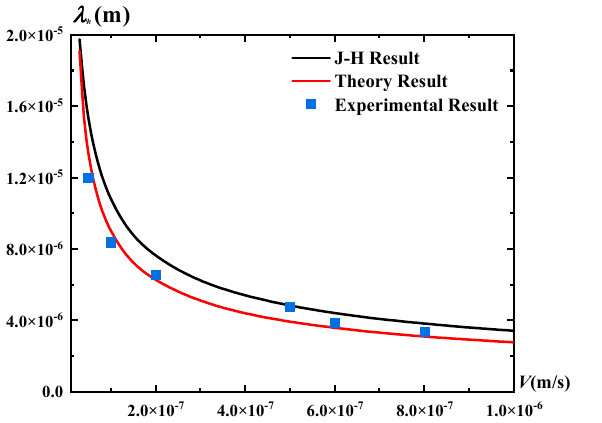
Figure 5. The critical eutectic spacing of λ ∗ with the speeding velocity V : λ ∗ and λ JH ∗ as a function of V , where w 0 = 0.40, G = 5000K/m.